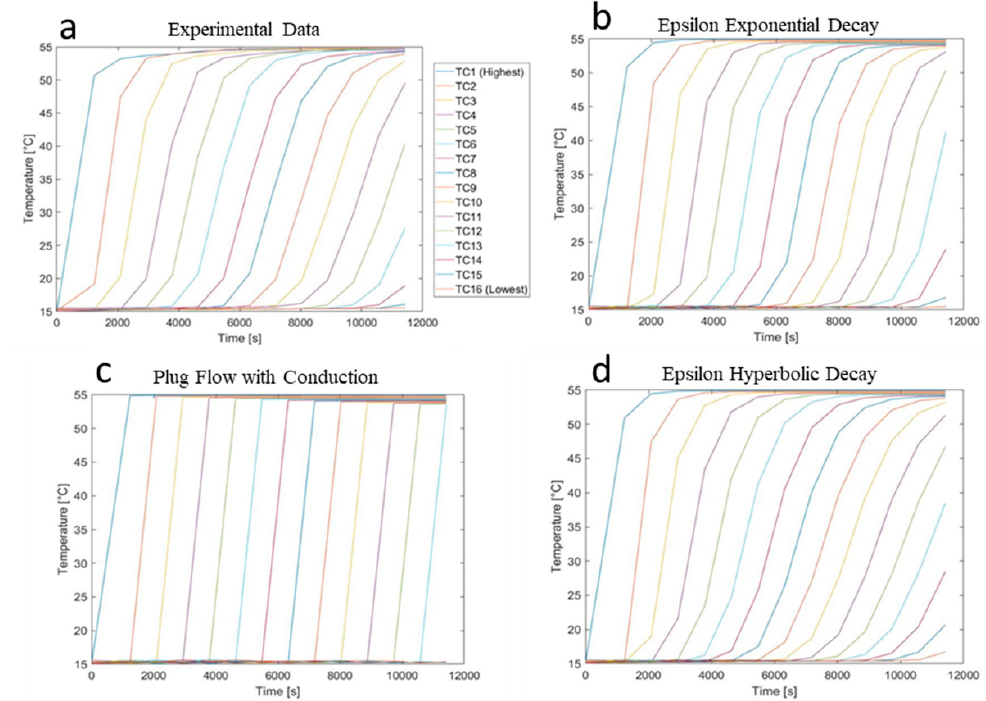
Figure 4. Source heating at 0.23 GPM flow rate. ( a ) Experimental data; ( b ) ε model using exponential decay; ( c ) plug-flow model with the inclusion of conduction in the water; and ( d ) ε model using hyperbolic decay.